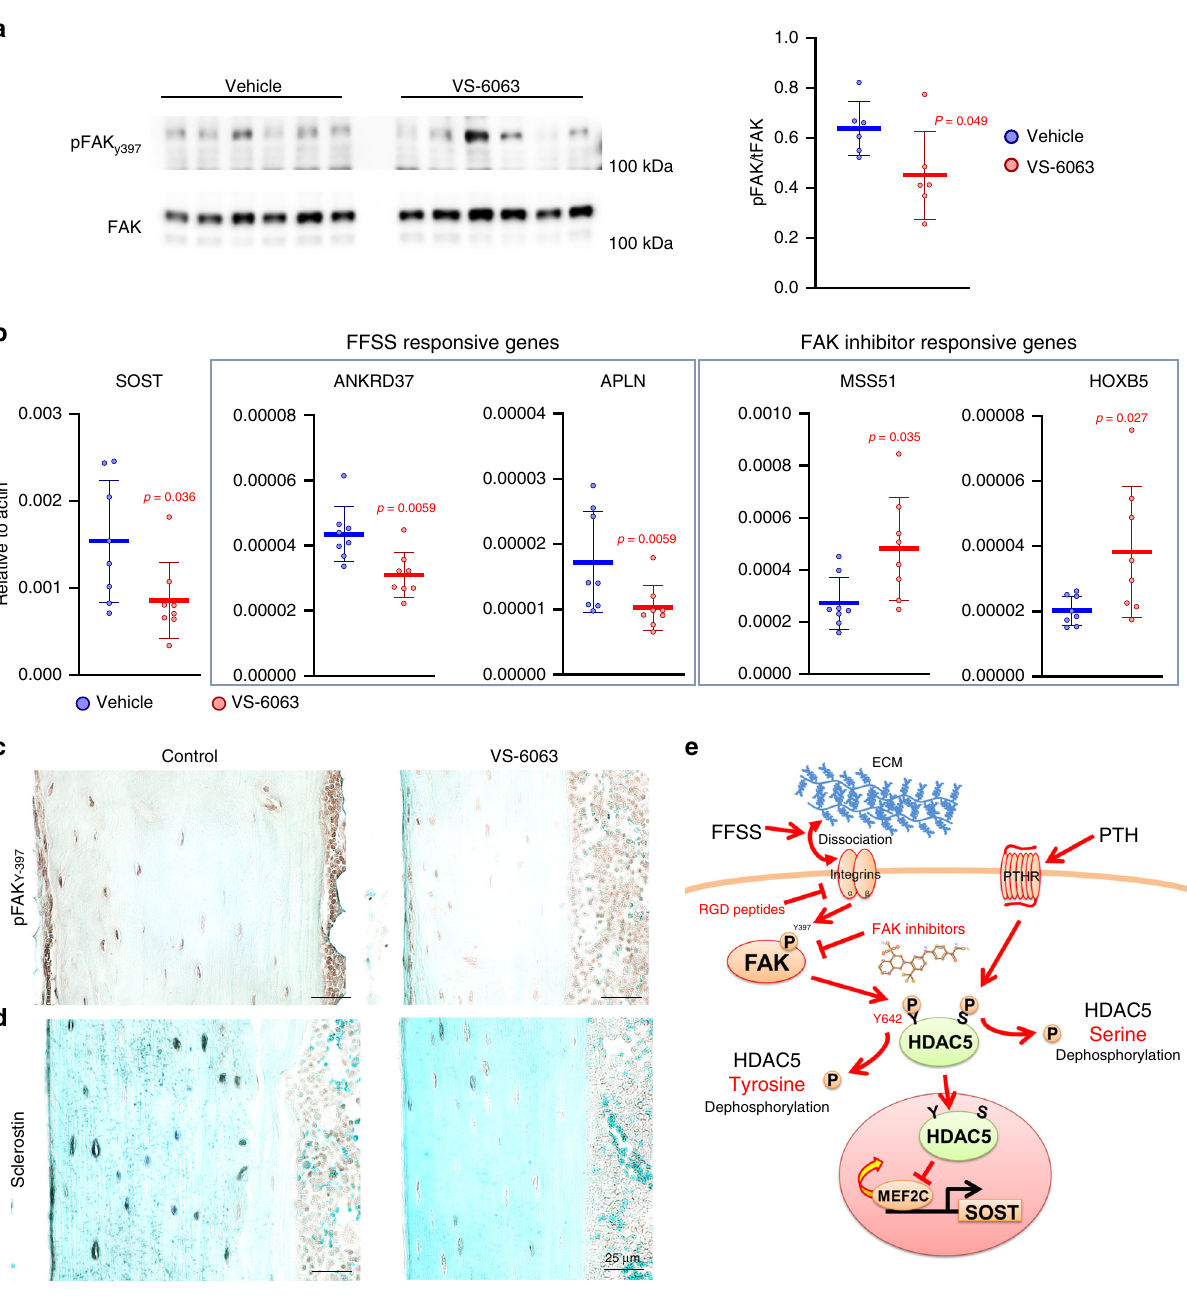
Fig. 8 FAK inhibitors reduce osteocytic Sost expression in vivo. a FAK inhibitor (VS-6063) was administrated by single intraperitoneal injection (60 mg kg − 1 ), and liver protein lysates were collected 5 h later and then subjected to immunoblotting as indicated. P -values vs vehicle. N = 6. b Cortical bone RNA was isolated after acute VS-6063 treated followed by RT-qPCR as indicated. FAK inhibitor signi fi cantly regulated expression of FFSS- and FAK inhibitor- sensitive transcripts. FFSS-responsive genes are those that were regulated by FFSS in vitro in our RNA-seq results. FAK inhibitor responsive genes are those that were upregulated by PF562271 in vitro in our RNA-seq results. P -values vs vehicle, n = 8 mice. c , d Immunohistochemistry was performed on tibia samples from mice in ( a ) and ( b ). Immunohistochemistry of mouse long bone. c phospho-FAK (Y397) and d Sclerostin levels were downregulated by FAK inhibitor treatment. e Model demonstrating the effects of fl uid- fl ow shear stress (FFSS)-mediated gene regulation in osteocytes, see text for details. Data are expressed as mean ± SEM. Each experiment was repeated three times ( c , d ). Source data are provided as a Source Data fi